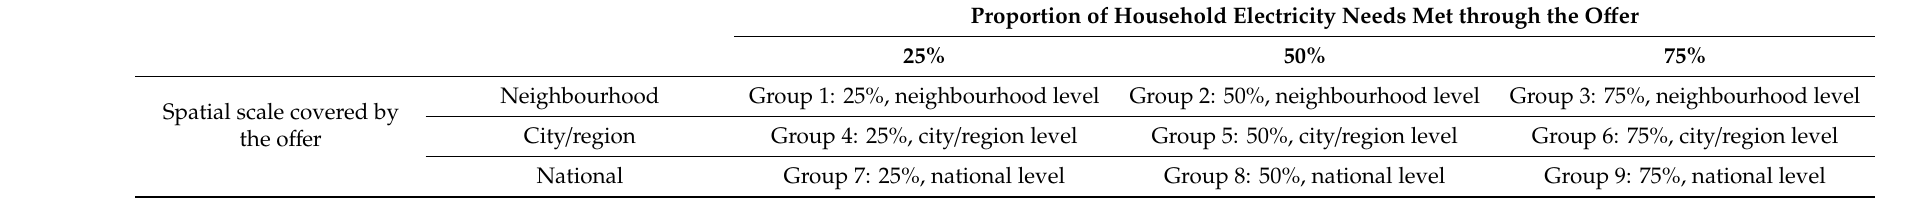
Table 2. 3 × 3 factorial design of Experiment